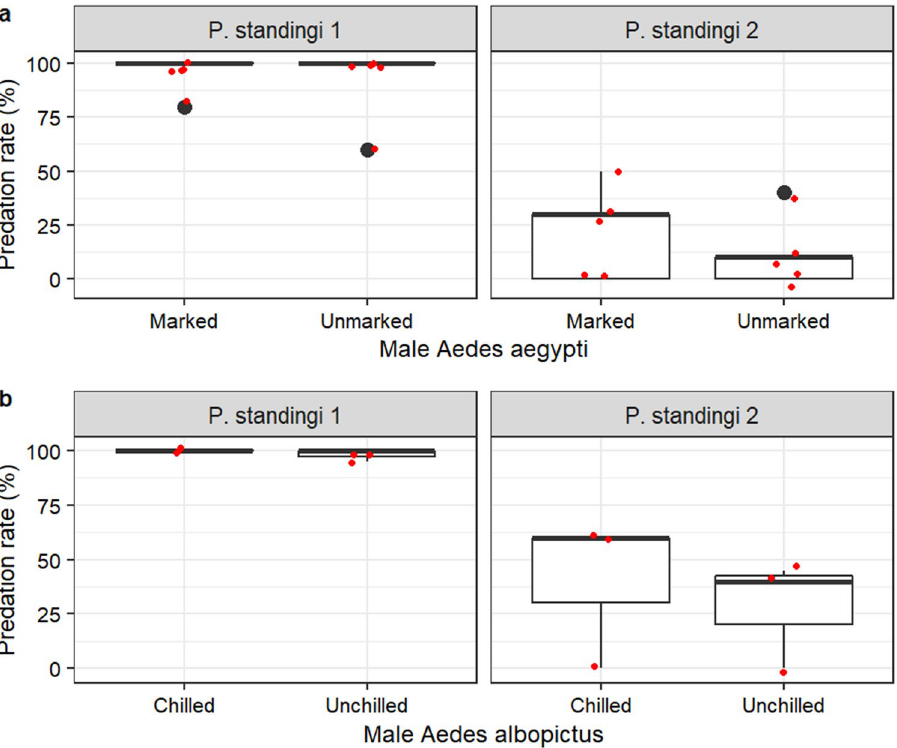
Figure 4. Effect of mosquito marking or chilling on their vulnerability to Phelsuma standingi predation. ( a ) marked versus unmarked male Aedes aegypti. ( b ) Chilled versus non chilled male Aedes albopictus